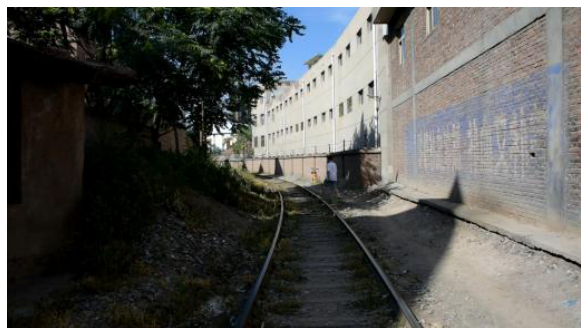
Fig. 7. The original image of the 401 th frame of video 1